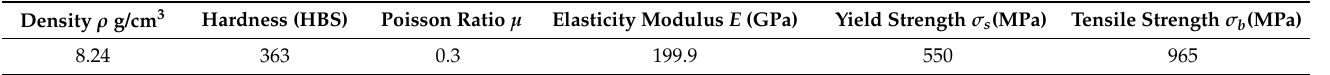
Table 2. Physical properties of superalloy Inconel 718.